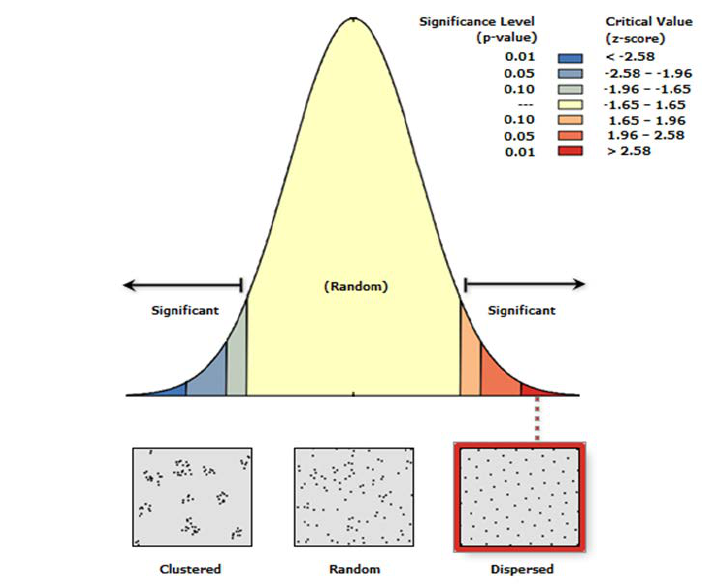
Figure 2. Nearest neighbor curve